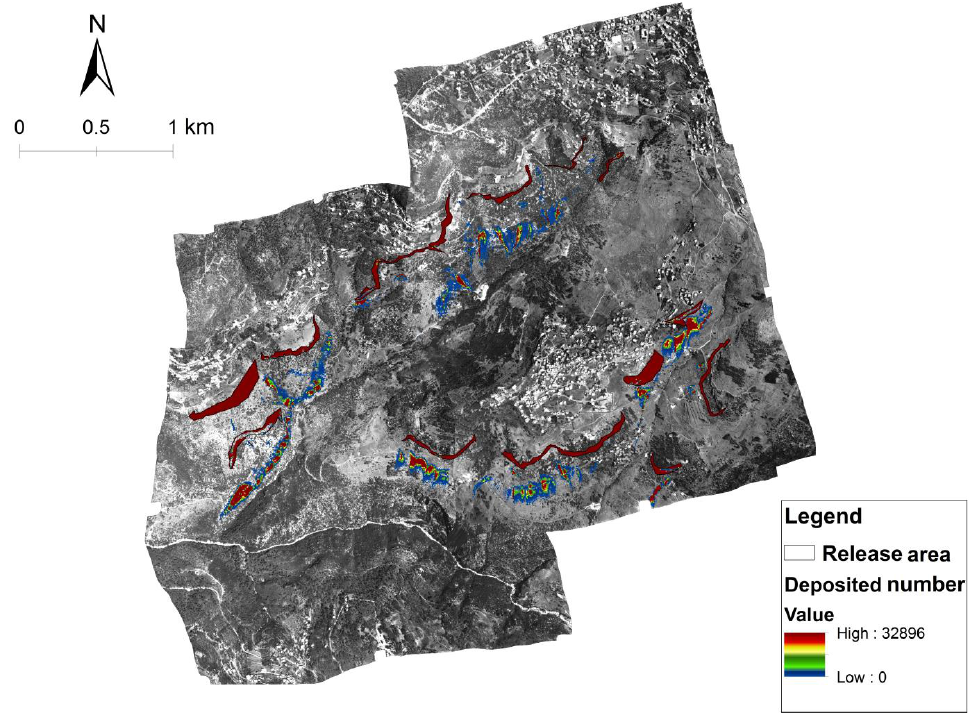
Figure 10. The obtained deposited number of rocks after 1000 simulations for the case scenario: gravity-induced.